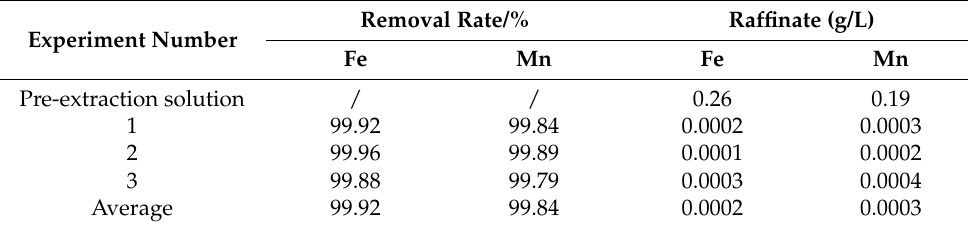
Table 4. Reproducibility of P204-N235 synergistic